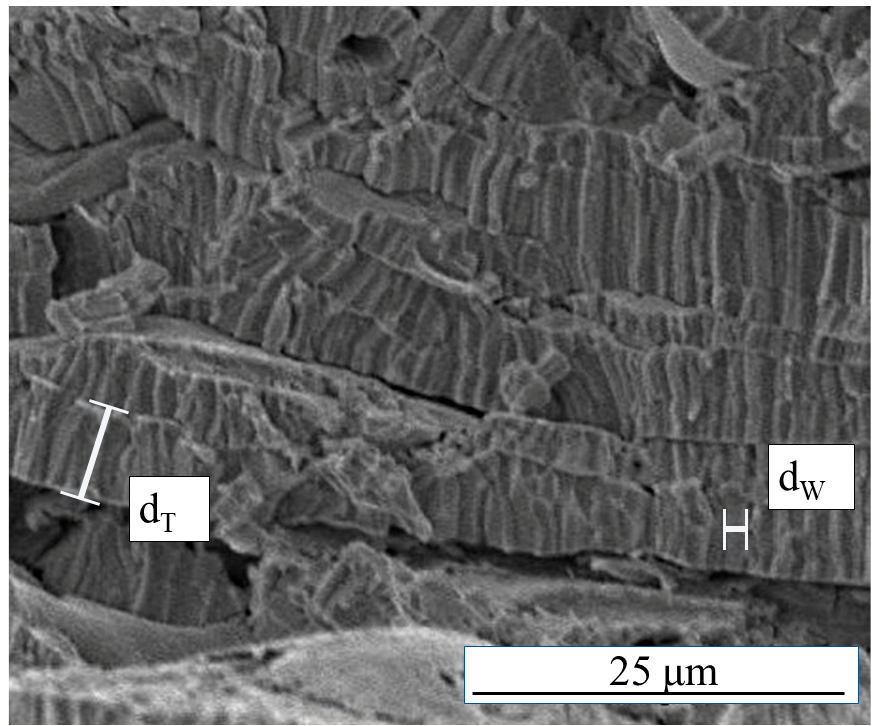
Figure 5. Complex and fine layered structure of W. Each layer consists of many columnar grains whose thickness d T is usually that of the layer, while the length substantially corresponds to the size of the original impacting droplet. The thickness d T and width d W are indicated in the figure.